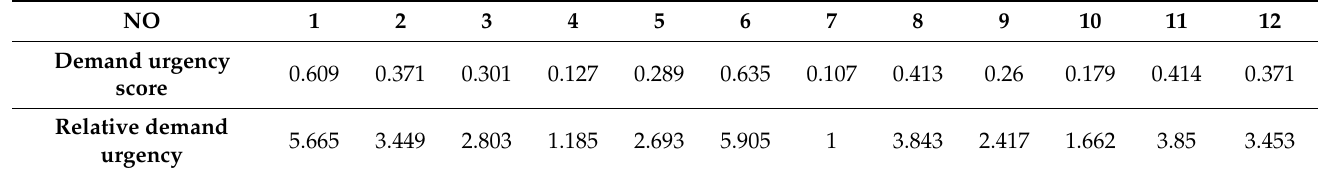
Table 7. Demand urgency scores for each medical device demand